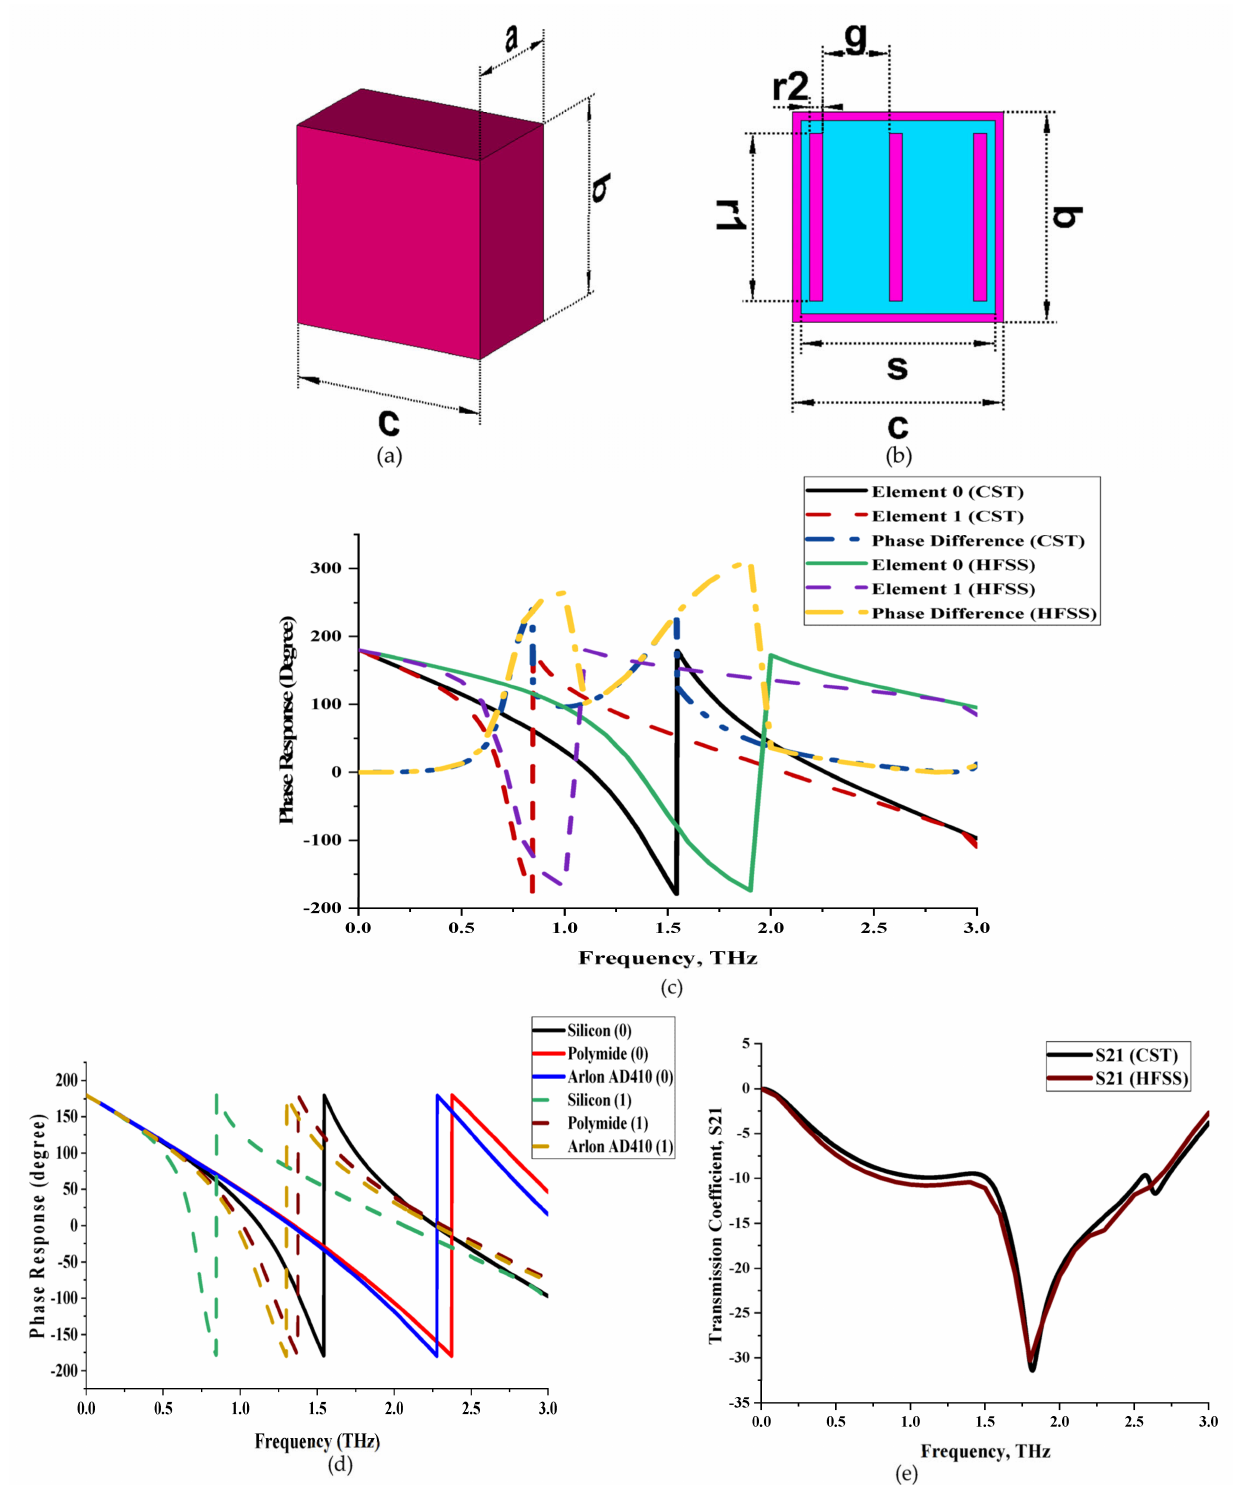
Figure 1. Unit cells of coding metamaterial: ( a ) element 0; ( b ) element 1; ( c ) phase responses from CST and HFSS; ( d ) phase response in various substrate material; ( e ) transmission